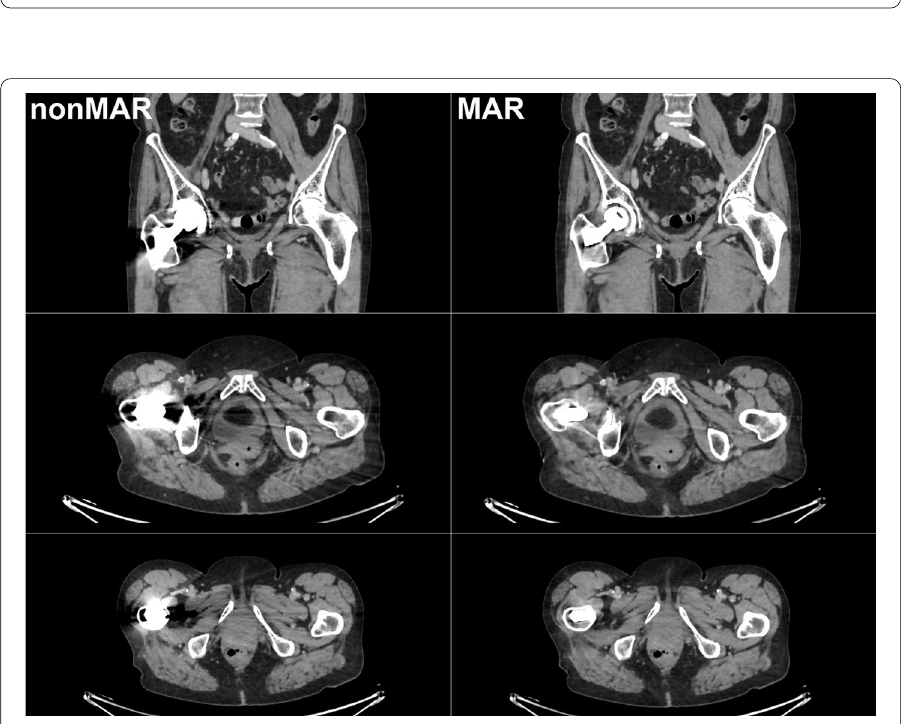
Fig. 12 CT images with and without MAR in a patient with unilateral hip prosthesis. Selected coronal (upper row) and axial (second and third row) slices are shown from CT reconstructed without MAR (left column) and CT reconstructed with MAR (right